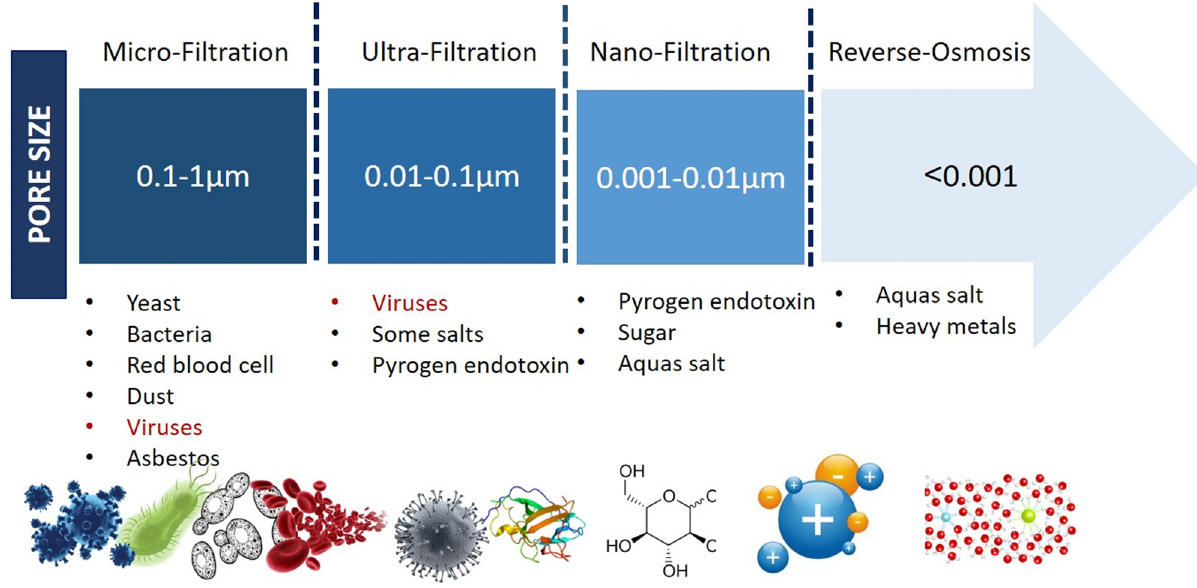
Figure 3: Classi fi cation of membrane processes according to pore size and criteria of